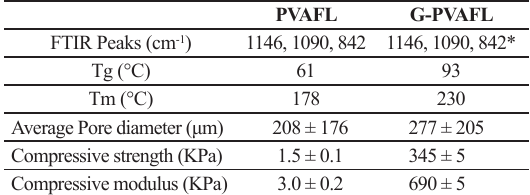
Figure 2. SEM images of PVAFL (a) and G-PVAFL foams (b) and size distribution of PVAFL (c) and G-PVAFL (d). Table 1. Physicochemical characterization of PVA